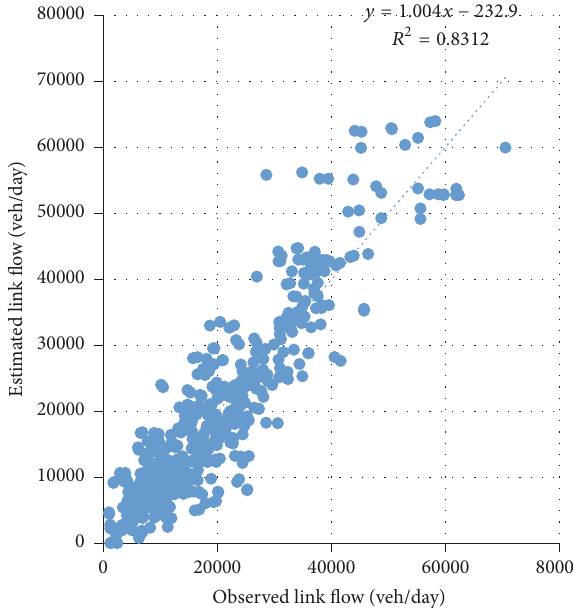
Figure 4: Result of day-long UE